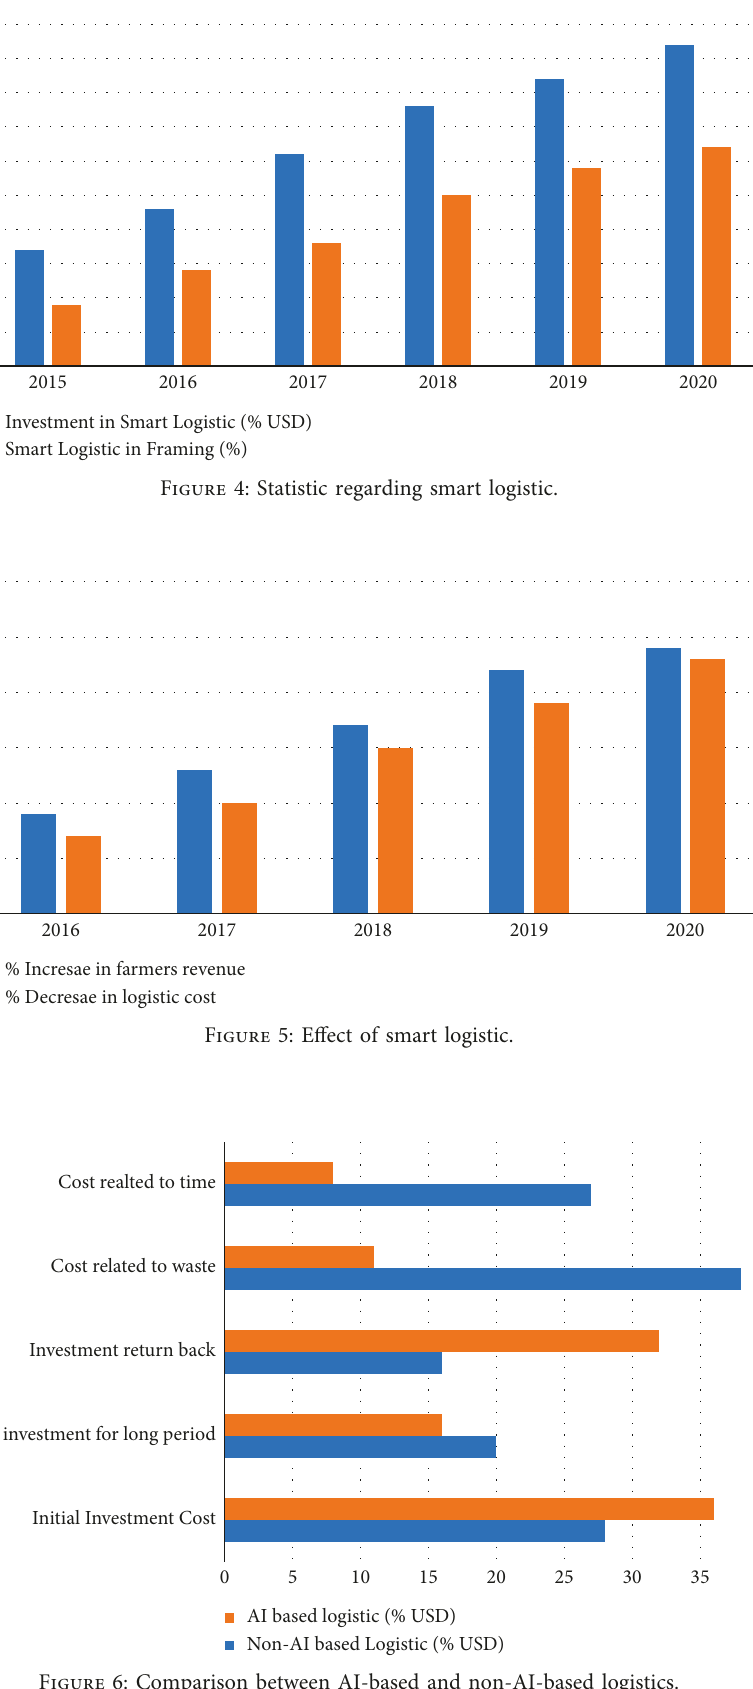
Figure 6: Comparison between AI-based and non-AI-based logistics.